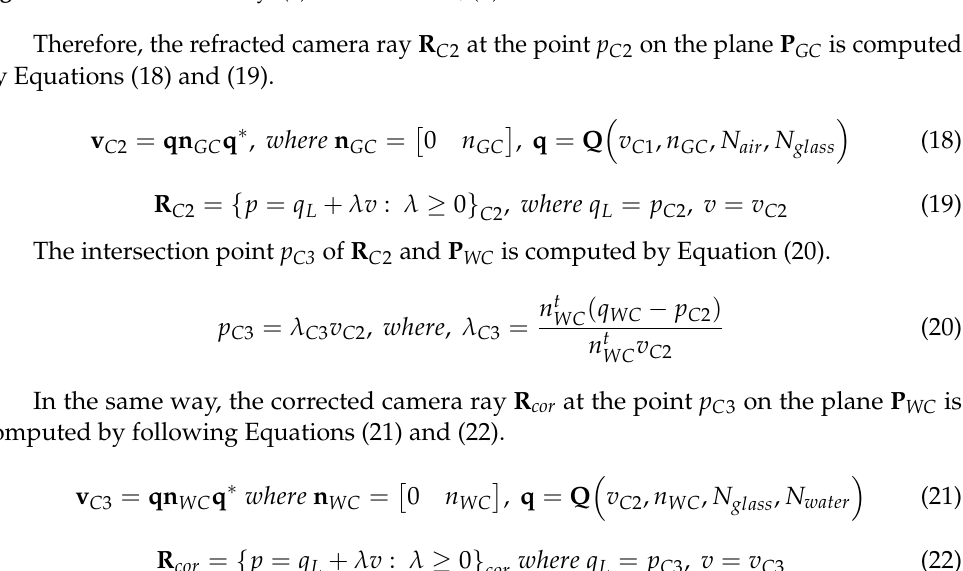
Figure 15. Refraction of a ray: ( a ) Isometric view; ( b ) Plane normal to the rotation vector.